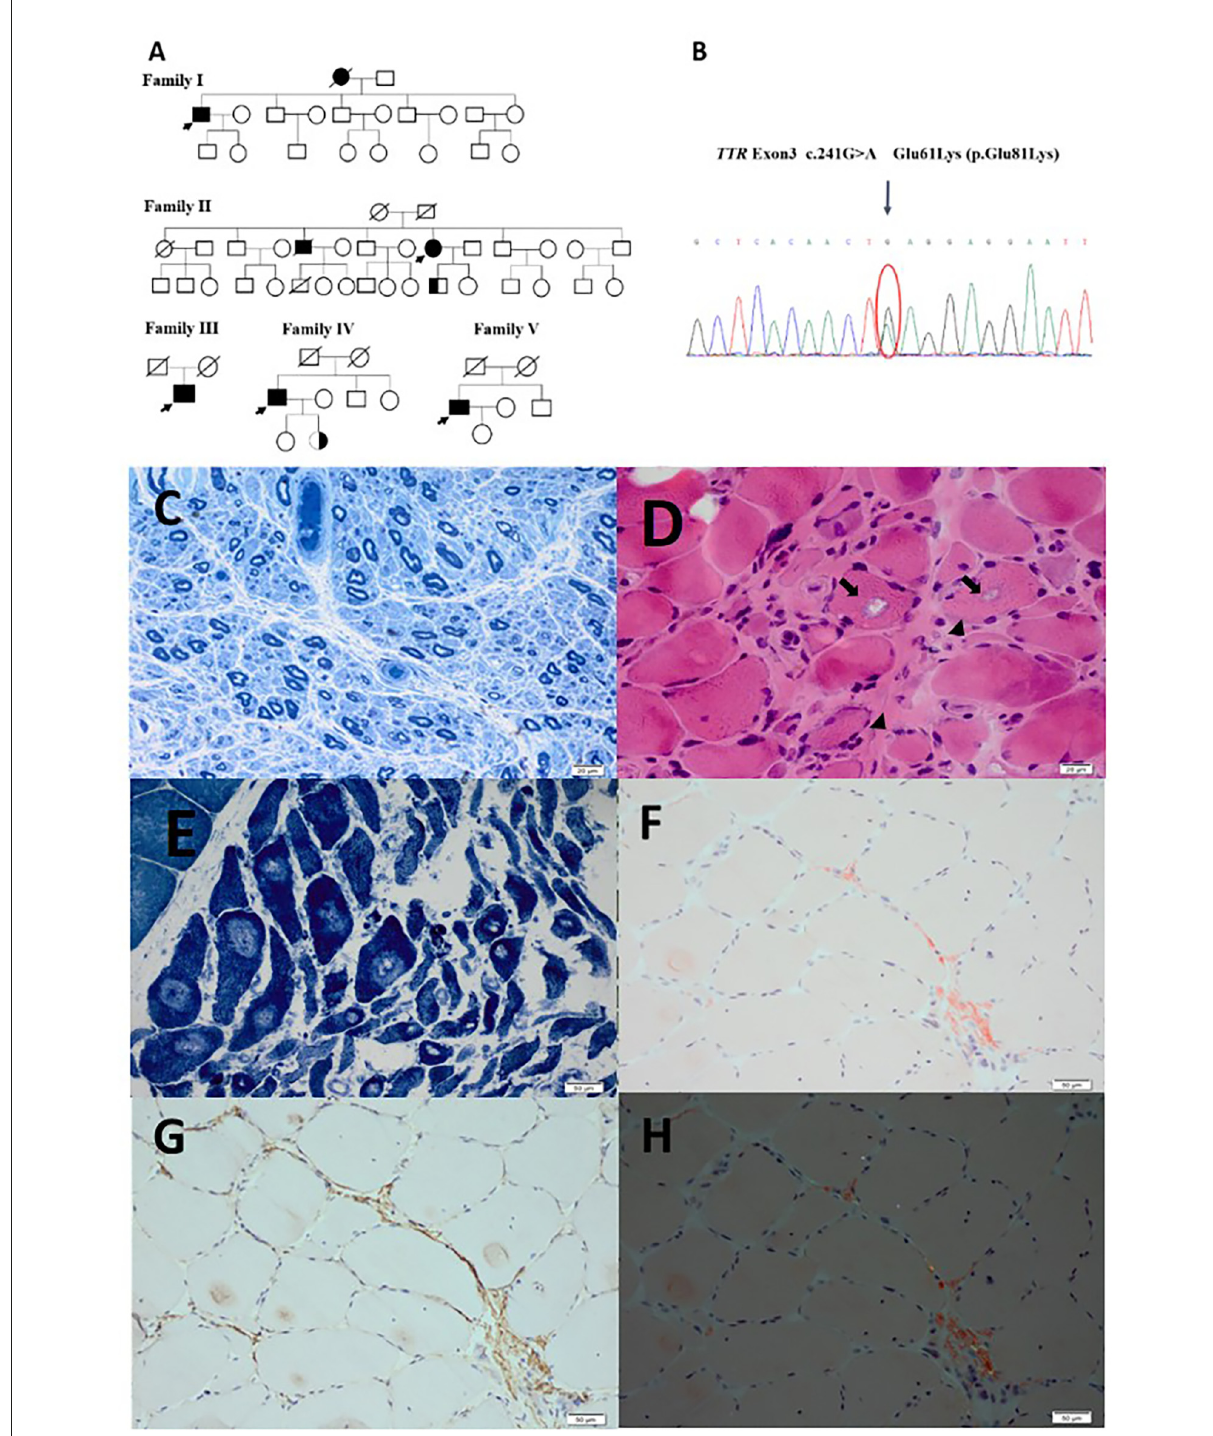
FIGURE1 (A) Genograms of fivepatients and two asymptomaticcarriers. (B) The sanger sequencingof patient with E61Kmutation on TTR gene. (C) Severely reduced myelinated fiber densities on the semithin section in patient 2. (D) Atrophic angular and round muscle (arrow heads) fibers and some muscle fibers with rimmed vacuoles (arrows) in patient 1. (E) Typical target-like muscle fibers with nicotinamide adenine dinucleotide tetrazolium reductase staining were found in patient 2. (F) Amyloid deposits in perimysium and perivascular areas on Congo-red staining in patient 2. (G) Amyloid deposits in perimysium and perivascular areas on TTR immunohistochemical staining in patient 2. (H) Apple-green birefringence viewed under polarized light in patient 2. Scale bar = 20 µ m in (C,D) . Scale bar = 1 µ m in (E,F,G,H)